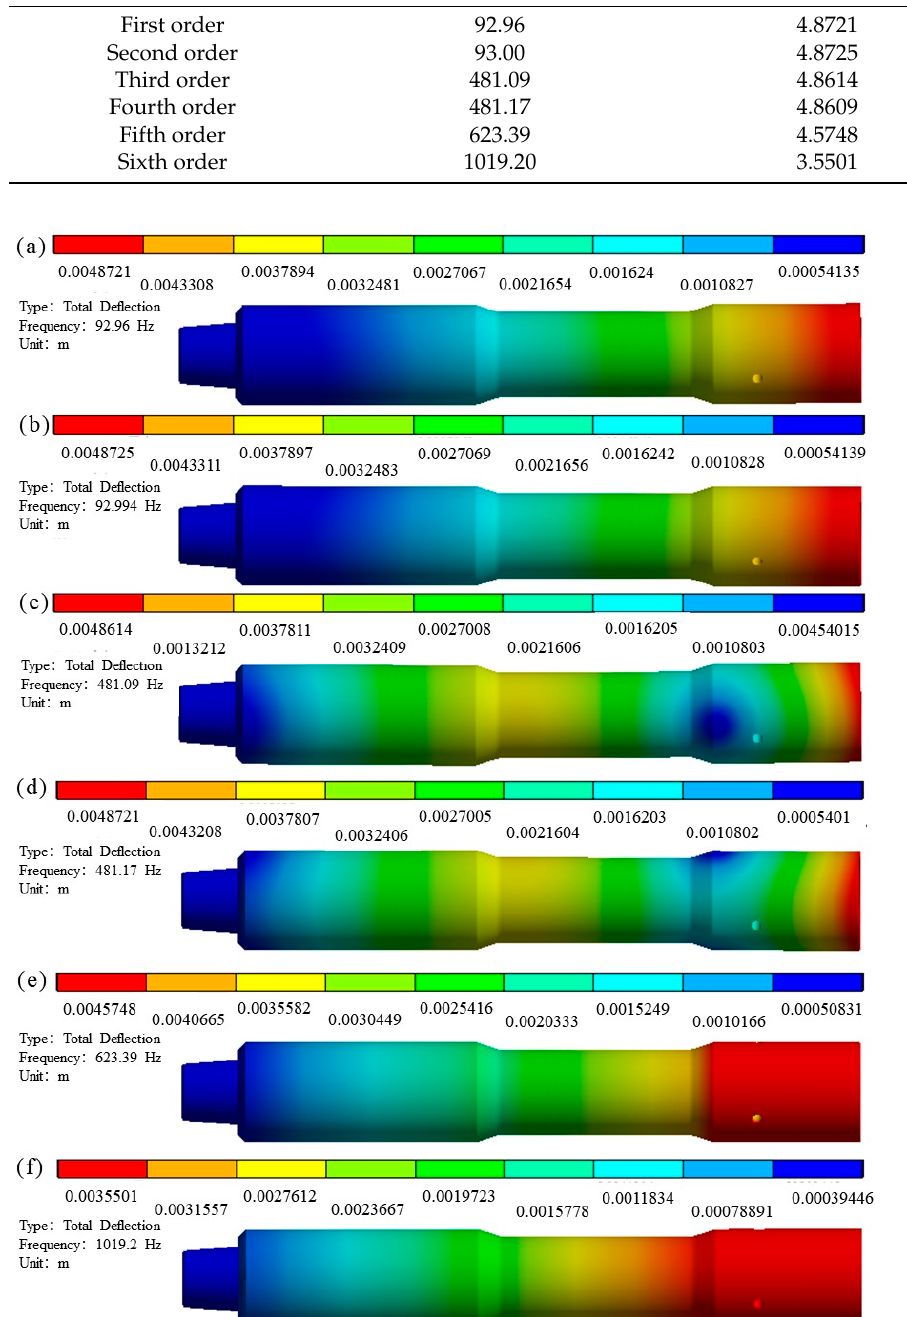
Figure 6. Schematic diagram of deformation of various vibration modes of the downhole solid–liquid separator. ( a ) First order mode; ( b ) second order mode; ( c ) third order mode; ( d ) fourth order mode; ( e ) fifth order mode; ( f ) sixth order